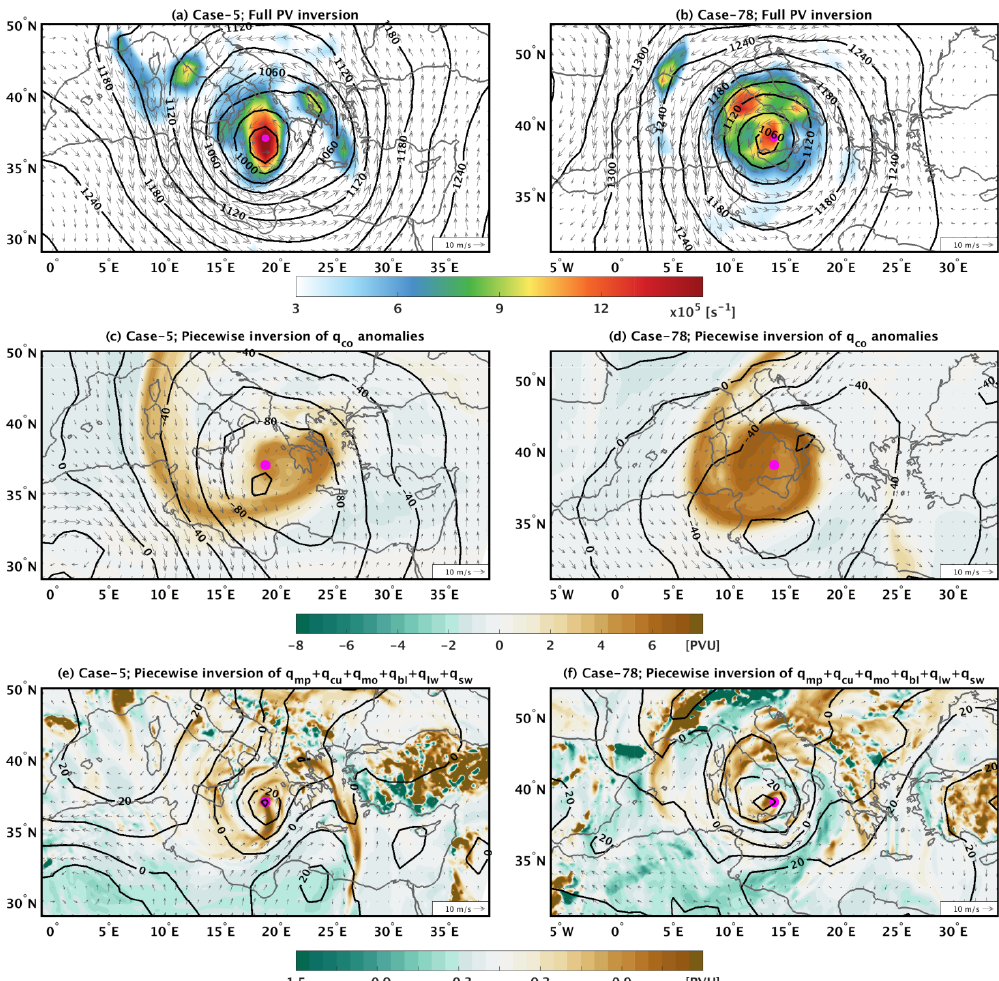
Figure 11. (a) Balanced relative vorticity (in colour), wind field (arrows) and geopotential height (in contours) at 850hPa after inverting the total atmospheric PV for cyclone case no. 5. The model outputs for this case are shown in the Supplement. (b) As in (a) but for case no. 78. (c) The field of q co at 300hPa (in colour) and the balanced wind (arrows) and geopotential height (contours) fields at 850hPa after inverting q co . (d) As in (c) but for case no. 78. (e) The field of the sum of all non-conserved PV tracers at 850hPa (colour), as well as the balanced wind field (arrows) and geopotential height (contours) at 850hPa after inverting all non-conserved PV. (f) As in (e) but for case no. 78. In all panels, the magenta dot depicts the cyclone’s